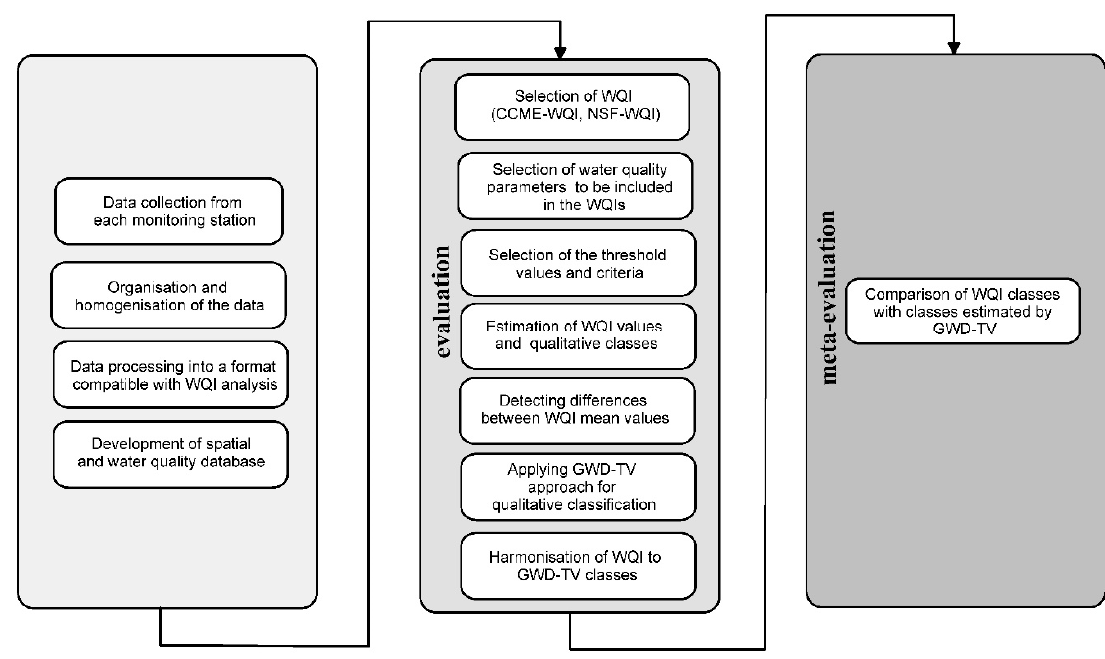
Figure 1. Flow diagram showing the applied methodology for meta-evaluation of WQIs.